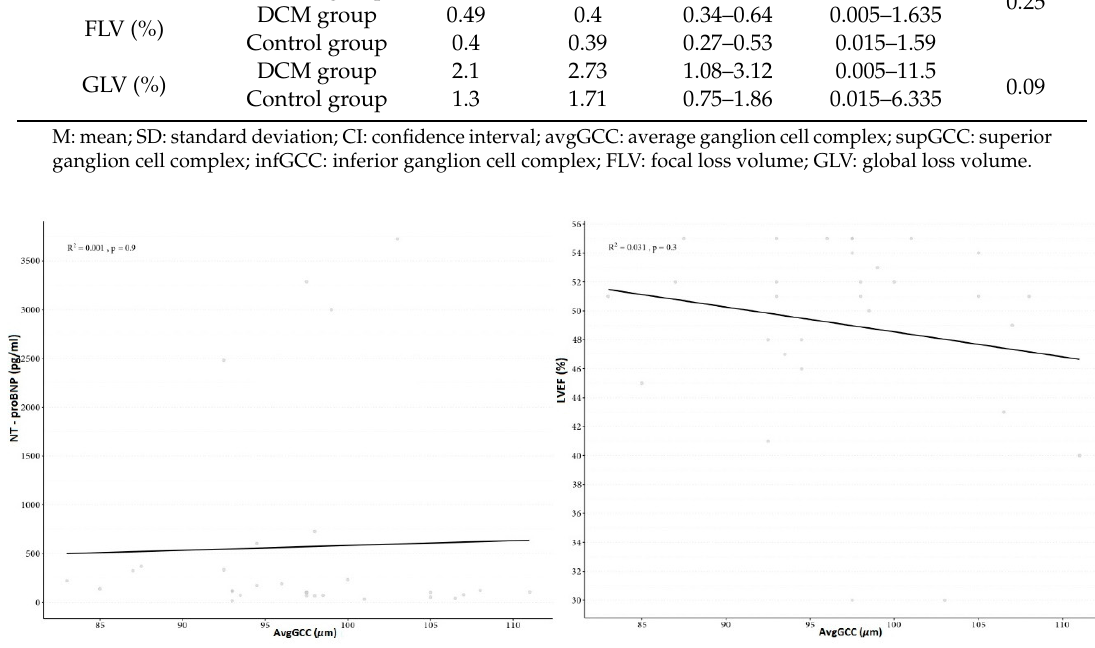
Figure 4. Graph of correlation between average ganglion cell complex thickness (avgGCC) and N-terminal (NT)-pro hormone BNP (NT-proBNP) and left ventricular ejection fraction (LVEF) in children with chronic heart failure in the course of dilated cardiomyopathy.